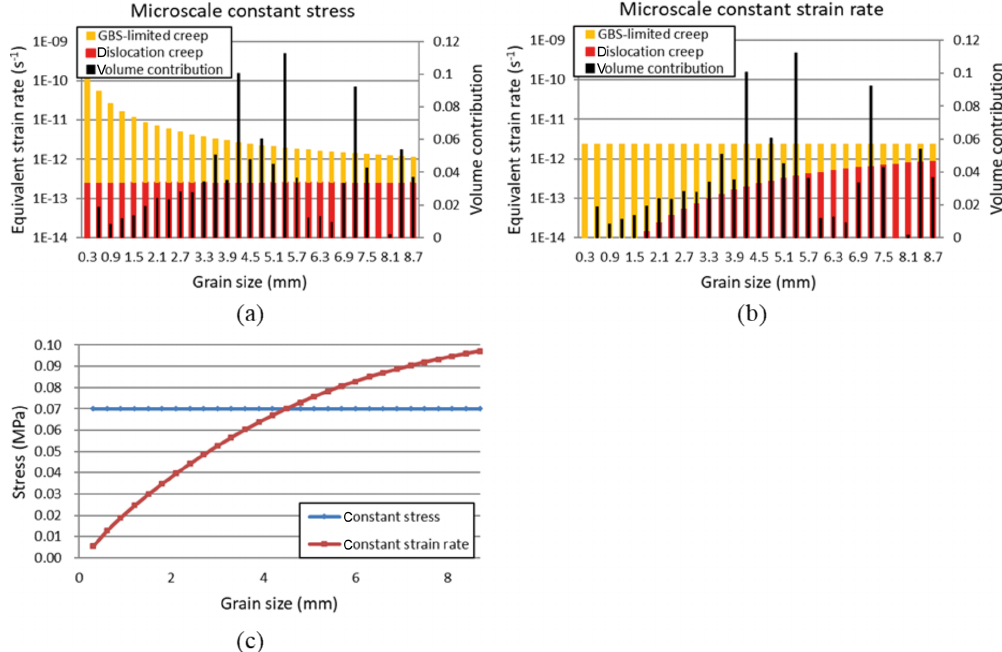
Figure 8. Grain size class versus log strain rate for an ice core section at 921m depth for (a) the microscale constant stress model, (b) the microscale constant strain rate model and (c) the stress supported by each grain size class of the grain size distribution. The results were calculated using the flow law parameters in Table 2. The bulk strain rate for this ice core section using the microscale constant stress and microscale constant strain rate model following Eqs. (7) to (10) are 41 × 10 − 12 and 24 × 10 − 12 s − 1 ,